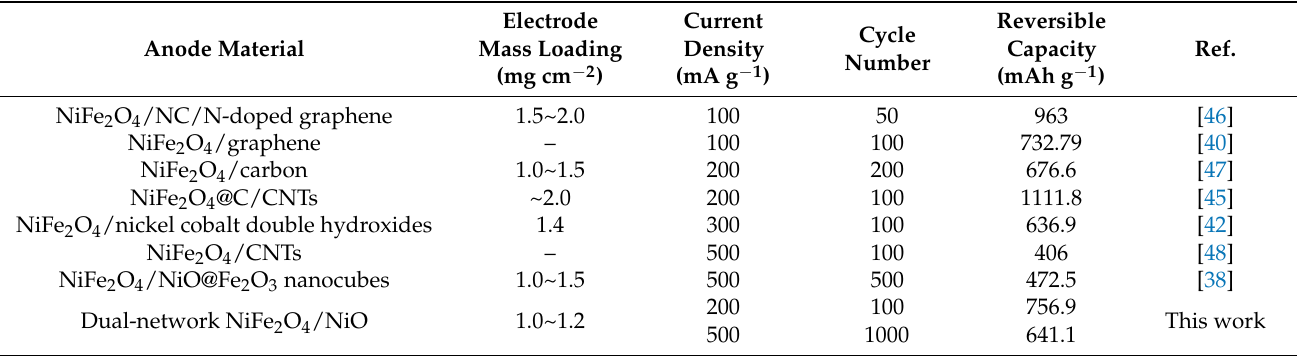
Table 1. The comparison of electrochemical performances of NiFe 2 O 4 -based materials for lithium-ion